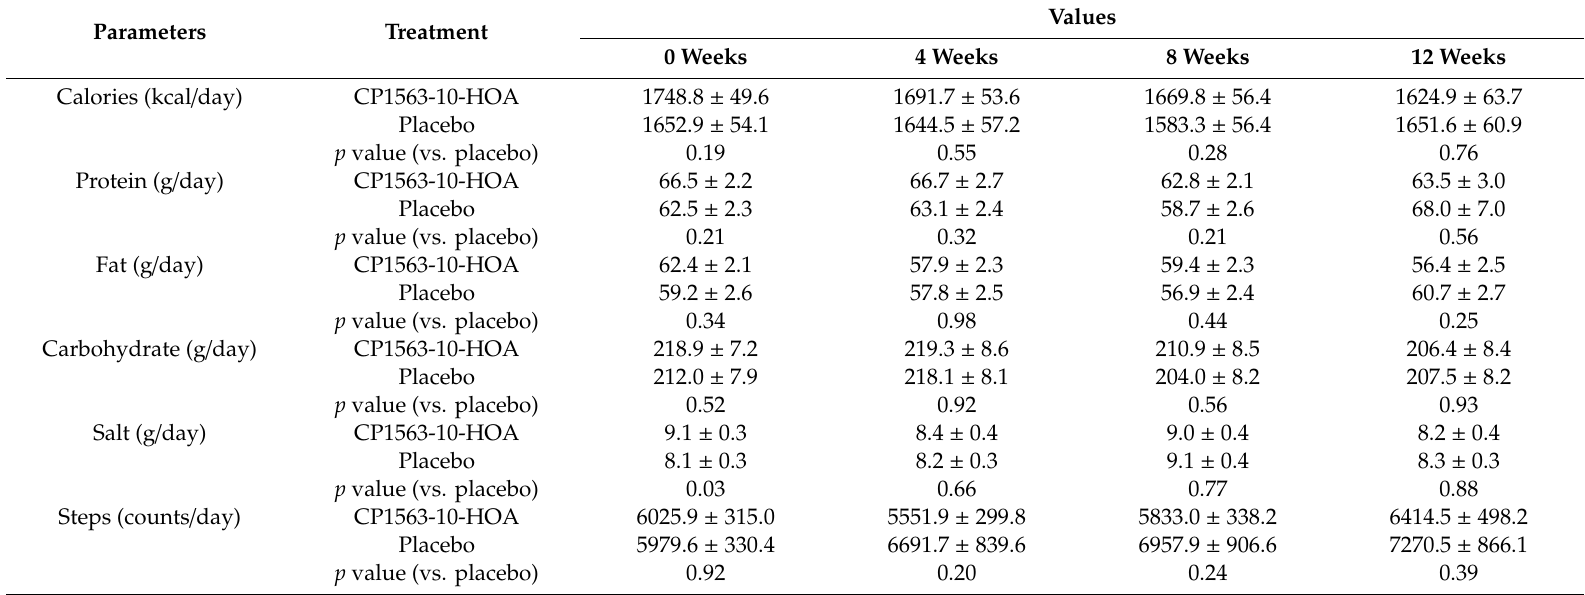
Table 2. Daily nutrient intake and physical